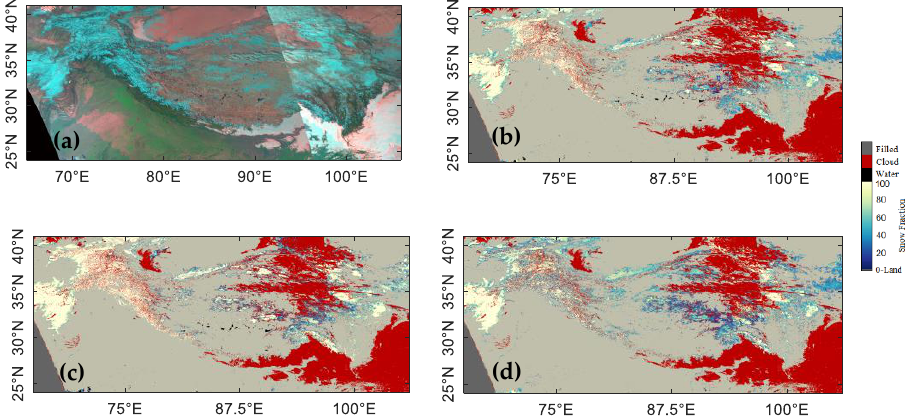
Figure 3. Comparison of the results from the three fractional-snow-cover algorithms on the 1 km scale for High Mountain Asia (25 January 1993): ( a ) the false colour image of AVHRR/2 bands 1, 2, and 3; ( b ) FSC from AVHRR/2 using the MESMA algorithm; ( c ) FSC from AVHRR/2 using the SI algorithm; ( d ) FSC from AVHRR/2 using the TEM algorithm.